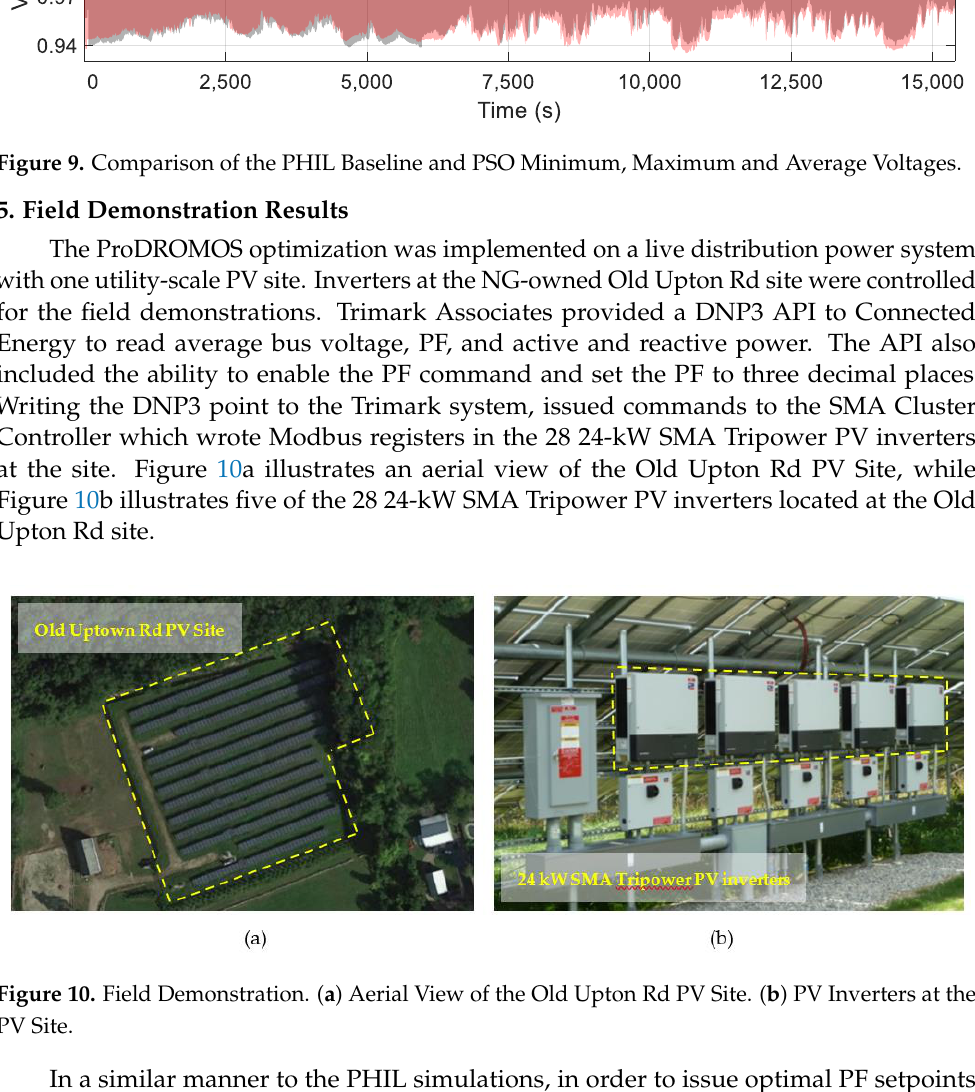
Figure 9. Comparison of the PHIL Baseline and PSO Minimum, Maximum and Average Voltages.